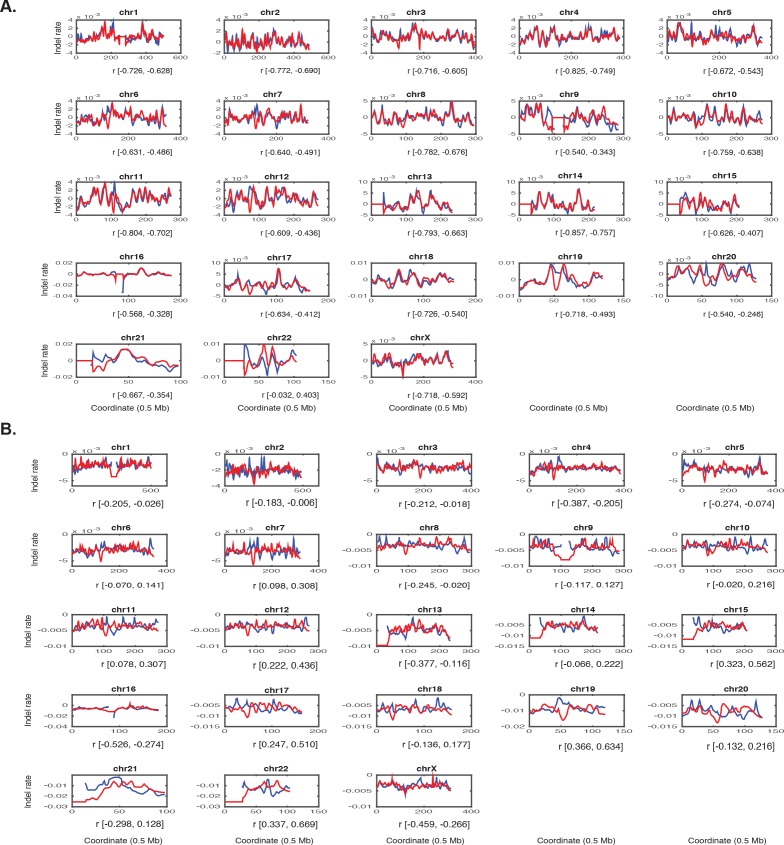
Genome-wide correlations of H3K27ac signal and mutation rate.(A) MSS mutations (red) overlaid on H3K27ac profiles (blue) of representative MSS (V410) line in bins of 0.5 Mb, for chromosomes 1–22 and X. Ninety-five percent confidence intervals for Pearson correlation coefficient are reported. (B) Same, but for MSI mutations overlaid on HCT-116 H3K27ac. See Figure 2—source data 1.